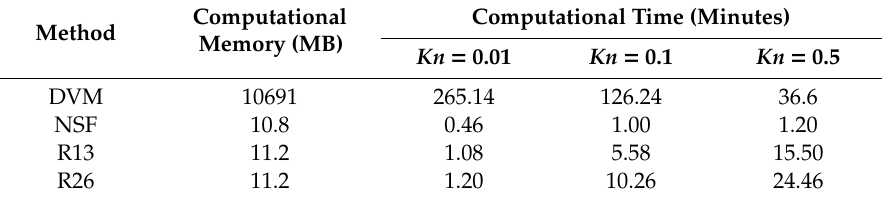
Table 3. Comparison of the computational cost between the DVM and moment